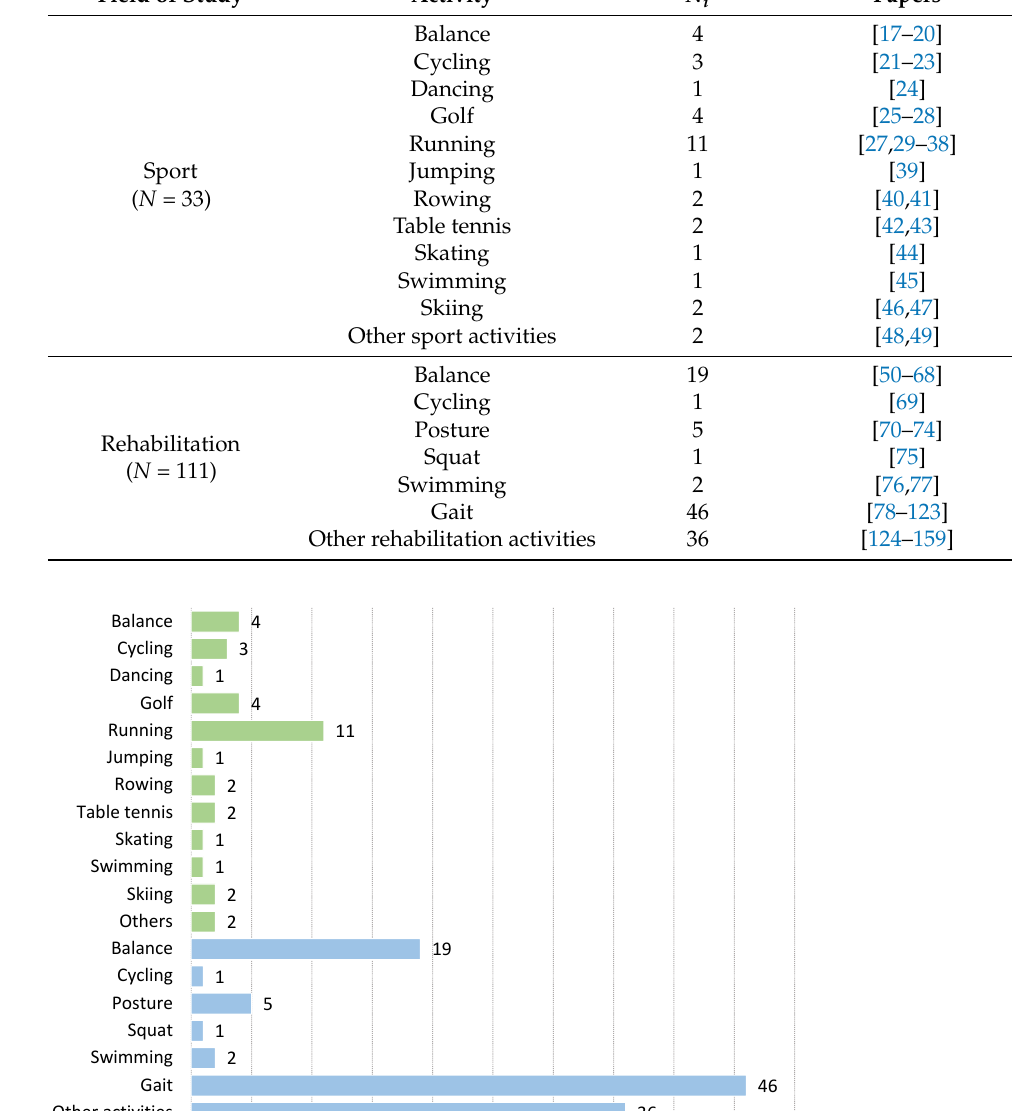
Figure 5. The number of papers according to different activities. Bars in green represent sport activities, bars in blue represent physical rehabilitation activities.